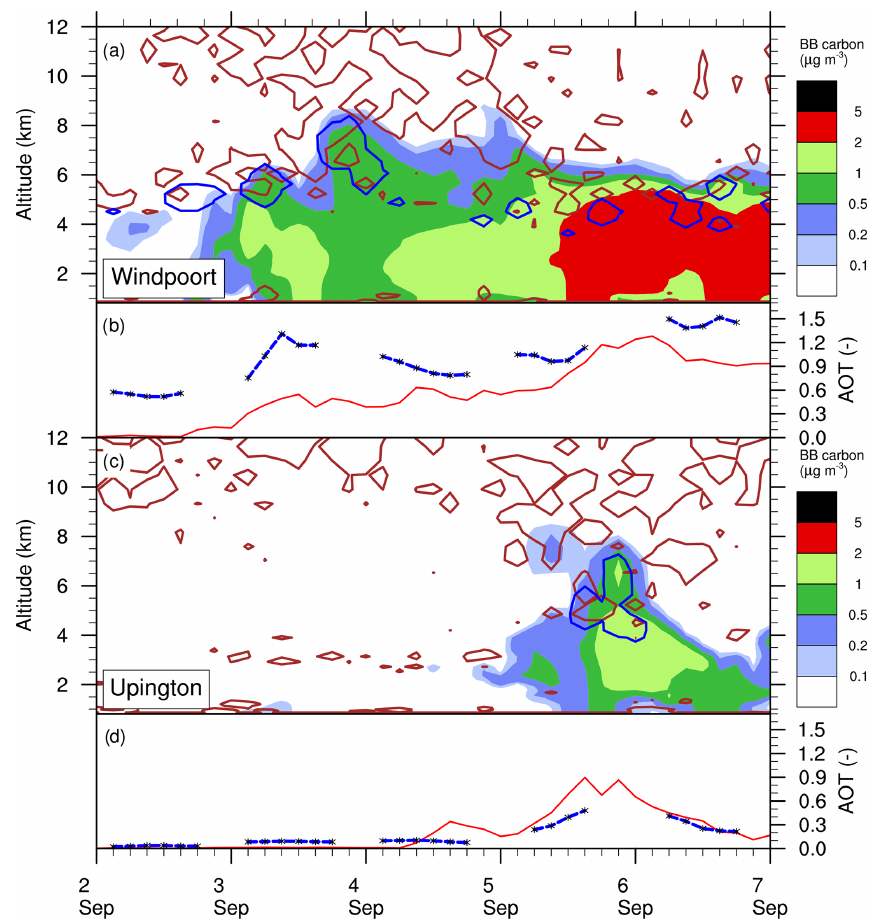
Figure 14. (a) Time–height evolution of BB carbon tracer concentration (color) between 1 and 6 September 2017 from the Meso-NH simulation over Windpoort. Blue contours represent liquid water every 0.1gkg − 1 , while brown contours represent potential vorticity every − 1 . 5PVU (potential vorticity unit, PVU = 10 − 6 Kkg − 1 m 2 s − 1 ). (c, d) AOT derived from Meso-NH (550nm, solid line, BBA only) and Sun-photometer (500nm, blue crosses). (b) Same as (a) but for